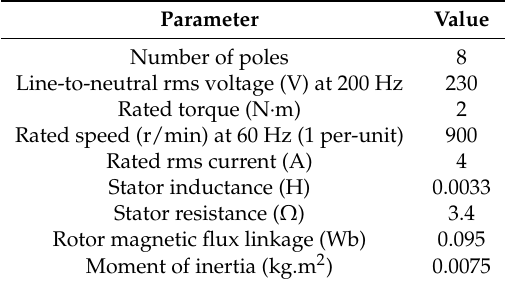
Table A1. Specifications and parameters of the Permanent Magnet Synchronous Motor